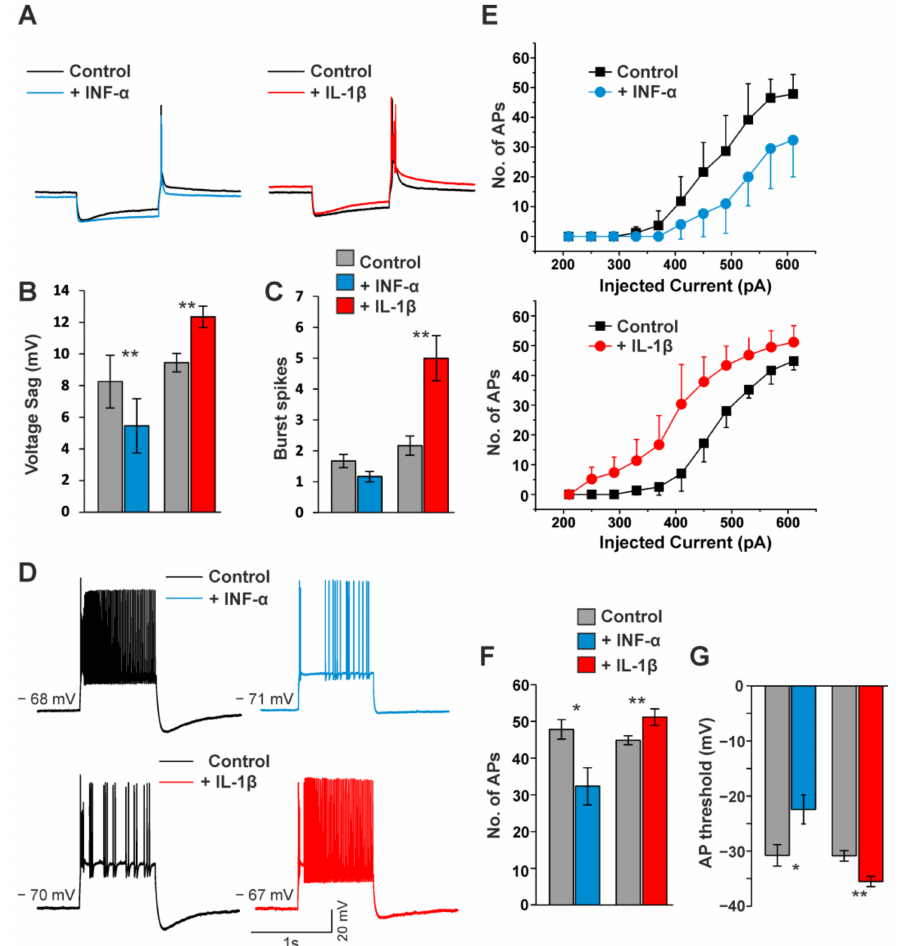
Figure 9. The effects of cytokines on firing properties of TC neurons of C57BL/6J mice. ( A ) Exemplary traces recorded in TC VB neurons as response to a hyperpolarizing pulse ( − 390 pA) under control conditions (black) and in presence of INF α (blue) and IL-1 β (red). ( B , C ) The bar graphs showing the I h -dependent voltage sag ( B ) and the number of action potentials in a LTS ( C ) following release from hyperpolarization. ( D ) Exemplary traces recorded in TC VB neurons as a response to a depolarizing pulse (+450 pA) under control conditions (black) and in presence of INF α (blue) and IL-1 β (red). ( E ) The graphs displaying the relationship of the injected current and the number of action potentials (APs). ( F , G ) The bar graphs indicating the number of APs ( F ) and the AP threshold ( G ). * and ** indicate p values less than 0.05 and 0.01,